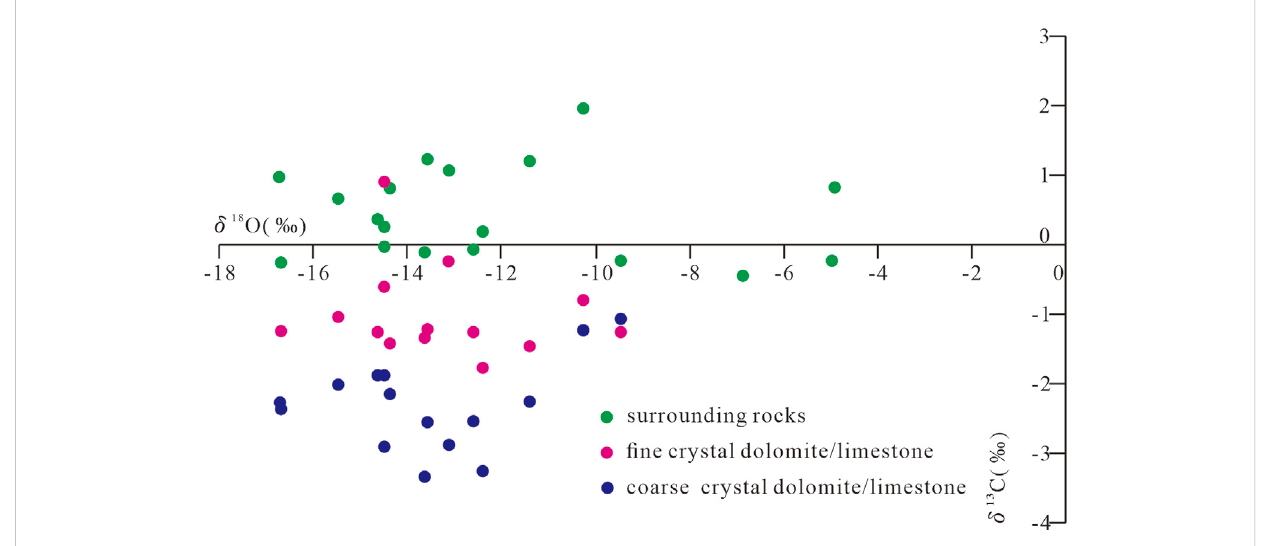
Cross-plot of C and O isotopes of surrounding rocks and structural fracture fi llings in the buried